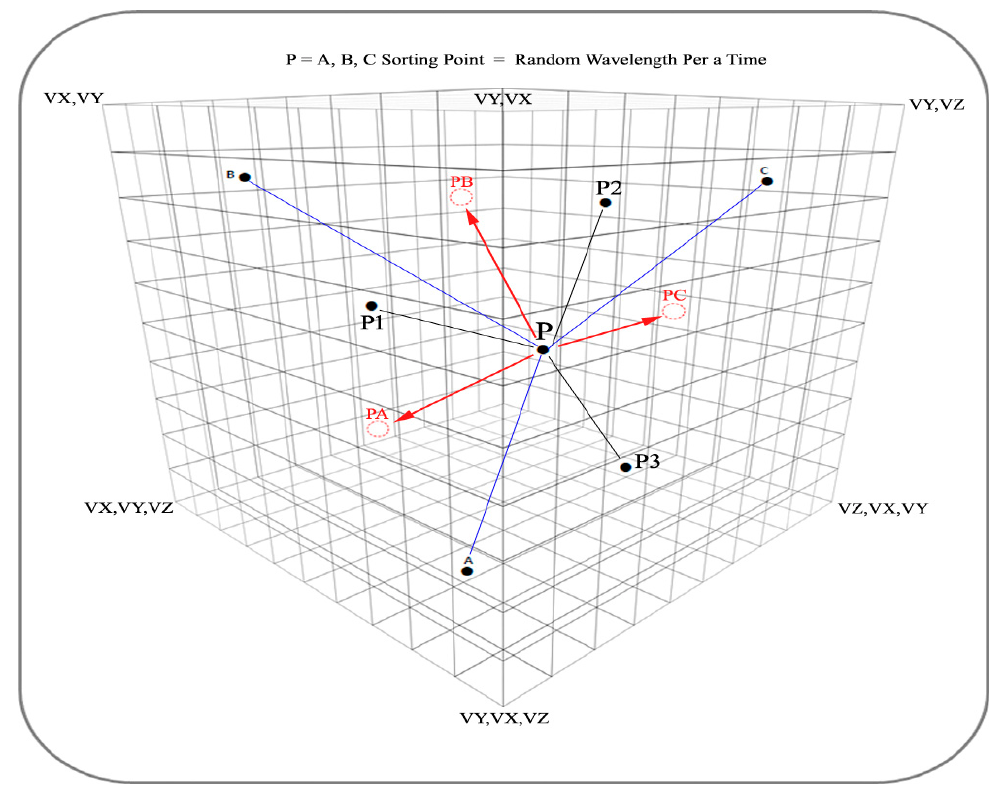
Figure 3. Converting a 3D cube into 2D